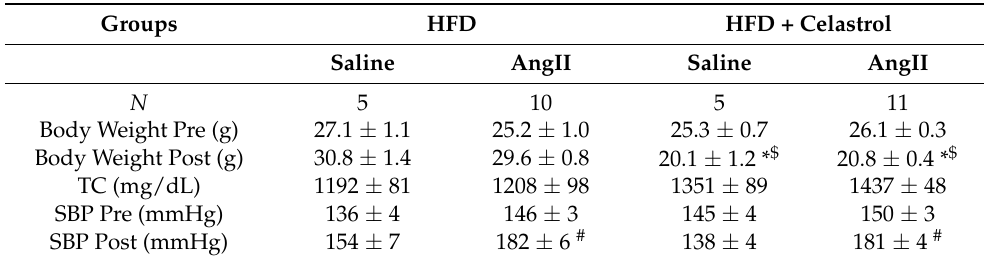
Table 2. Effects of Celastrol in male Ldl receptor -/- mice infused with saline or low dose of AngII (500 ng/kg/min). Groups HFD HFD + Celastrol Saline AngII Saline AngII N 5 10 11 Body Weight Pre (g) 27.1 ± 1.1